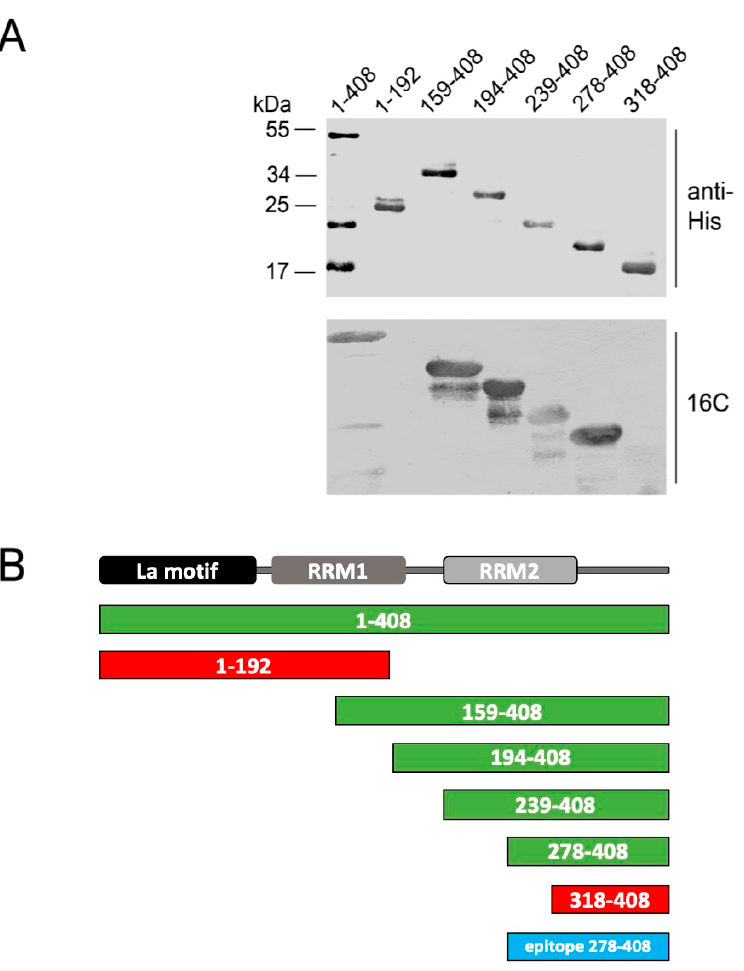
Figure 13. Epitope mapping of the IgM type anti-La mab (16C). Of all IgM type anti-La mabs, only epitope mapping data were obtained for the anti-La mab (16C). As it failed to react with HeLa cell extracts but reacted with full length La protein recombinantly expressed in E. coli (aa 1–408), N- and C-terminally truncated La deletion mutants were prepared, expressed in E. coli, and isolated via nickel-NTA affinity chromatography. ( A ) After SDS-PAGE and immunoblotting, the La deletion mutants were detected using either anti-His antibodies or the 16C anti-La mab. For detection of any immune reactivity of the anti-La mab (16C), we had to apply 10-fold the amount of protein as compared with the anti-His antibody; ( B ) Schematic summary of the selected La fragments. Immunoreactive La fragments are highlighted in green. La fragments which failed to react with the anti-La mab (16C) are shown in red. The identified epitope region is highlighted in blue.